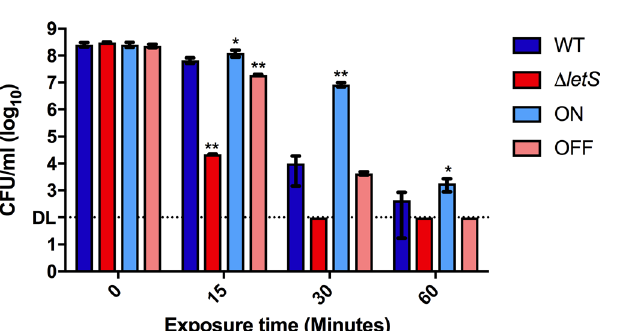
Figure 3. Deletion of letS affects sensitivity to heat shock. The WT, ∆ l etS , ON and OFF strains were suspended in water for 2 hours and subsequently exposed to a 55 °C water bath for 15, 30 or 60 minutes. CFU counts were enumerated on CYE agar before and after the heat shock treatment. DL, detection limit. An unpaired, one-tailed Student’s t-test was used to assess statistical significance versus WT. * p < 0.05; ** p <